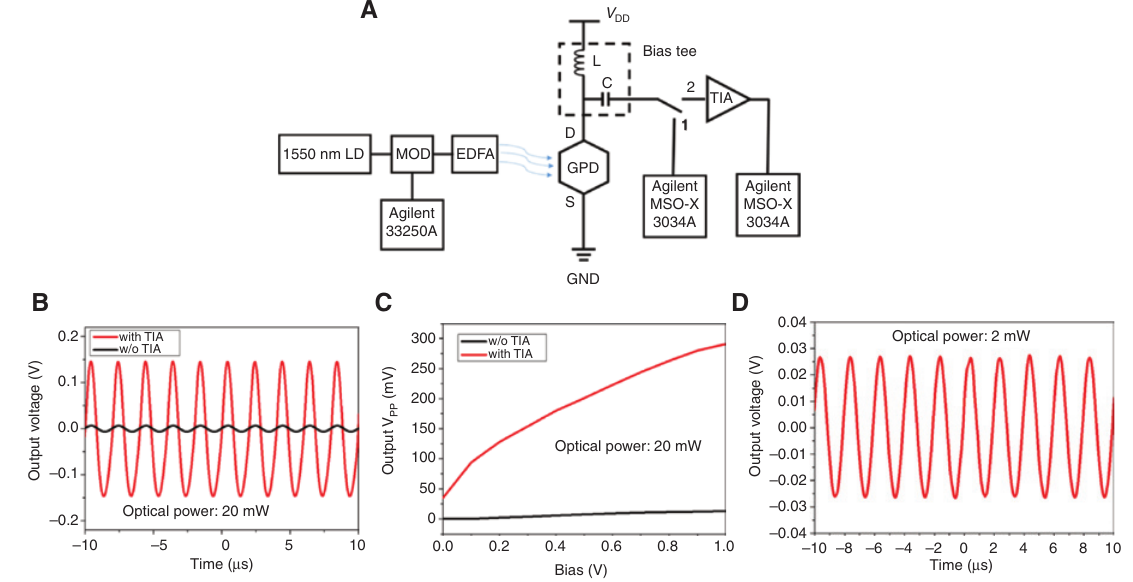
Figure 6: Dynamic photoresponse of optical receivers. (A) Test circuitry for dynamic responses of GPD and the optical receiver. (B) Output voltages of the photocurrent signals at 1 V bias in mode 1 (black) and mode 2 (red). (C) Output V values of mode 1 (black) and mode 2 (red) as a function of the bias. (D) Output voltages of the optical pp receiver at 1 V bias under a 2 mW effective optical power with a frequency of 500